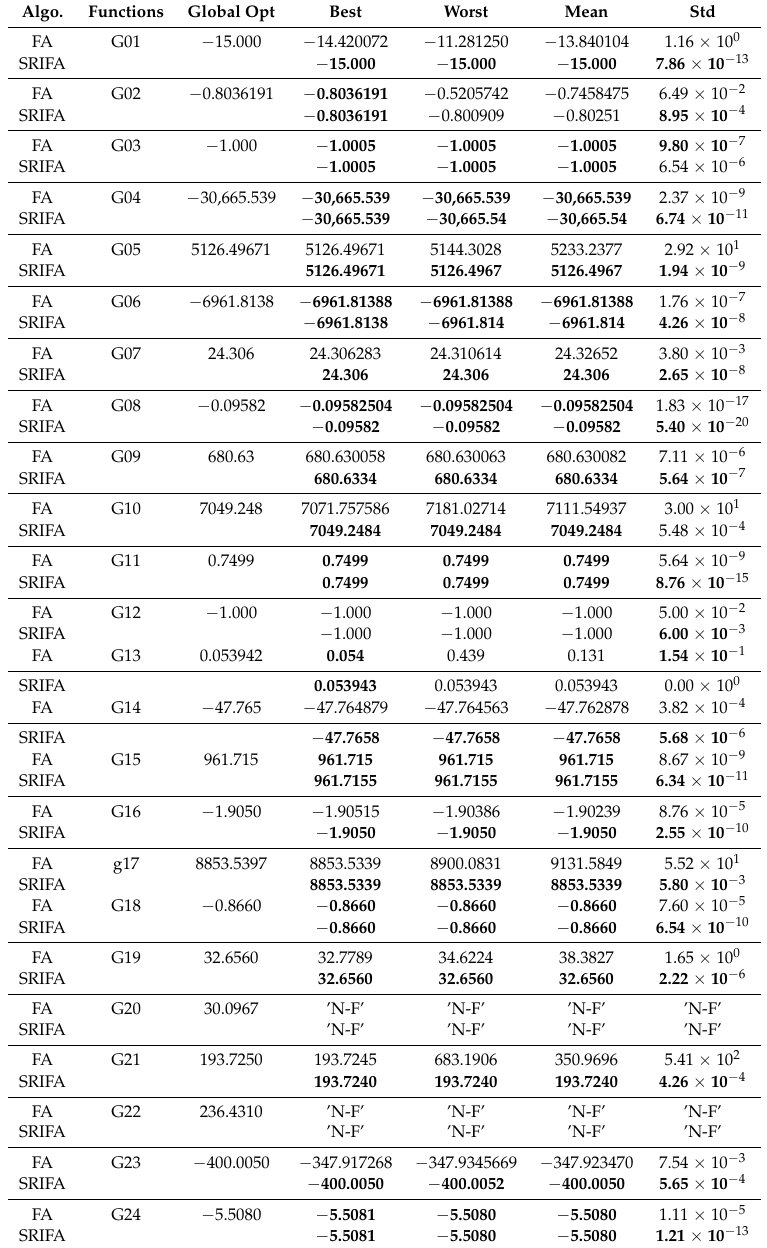
Table 5. Statistical results obtained by SRIFA and FA on 24 benchmark functions over 25